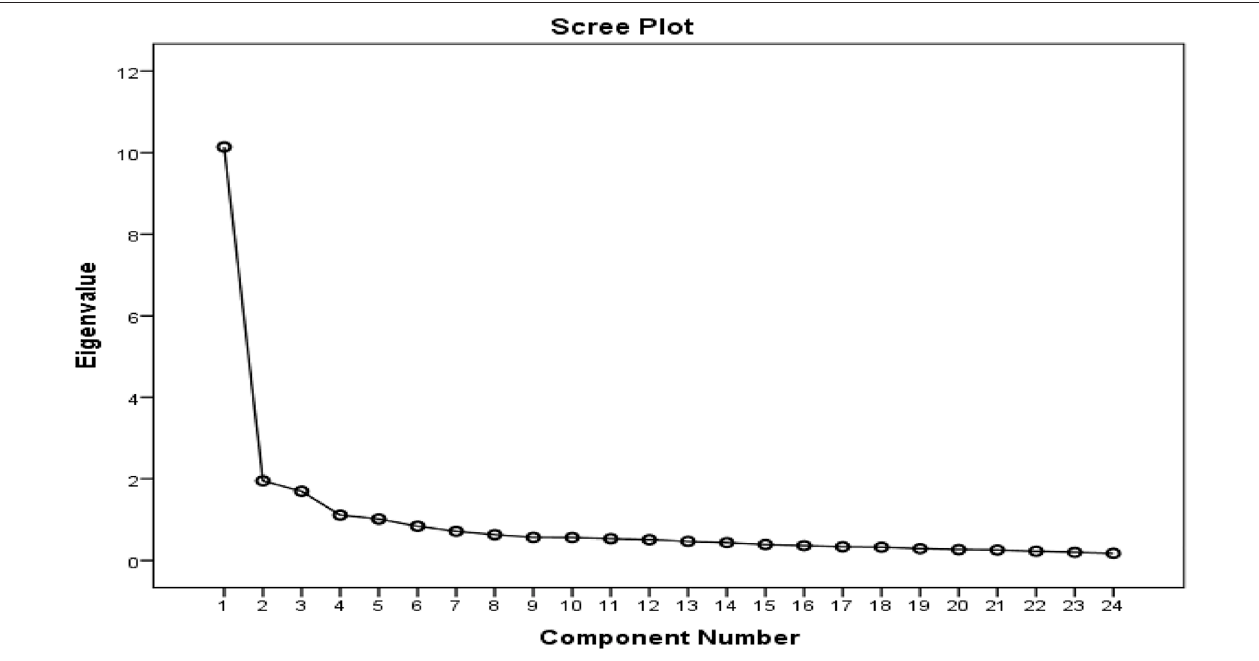
FIGURE 2 | Scree plot and component factors resulting from the